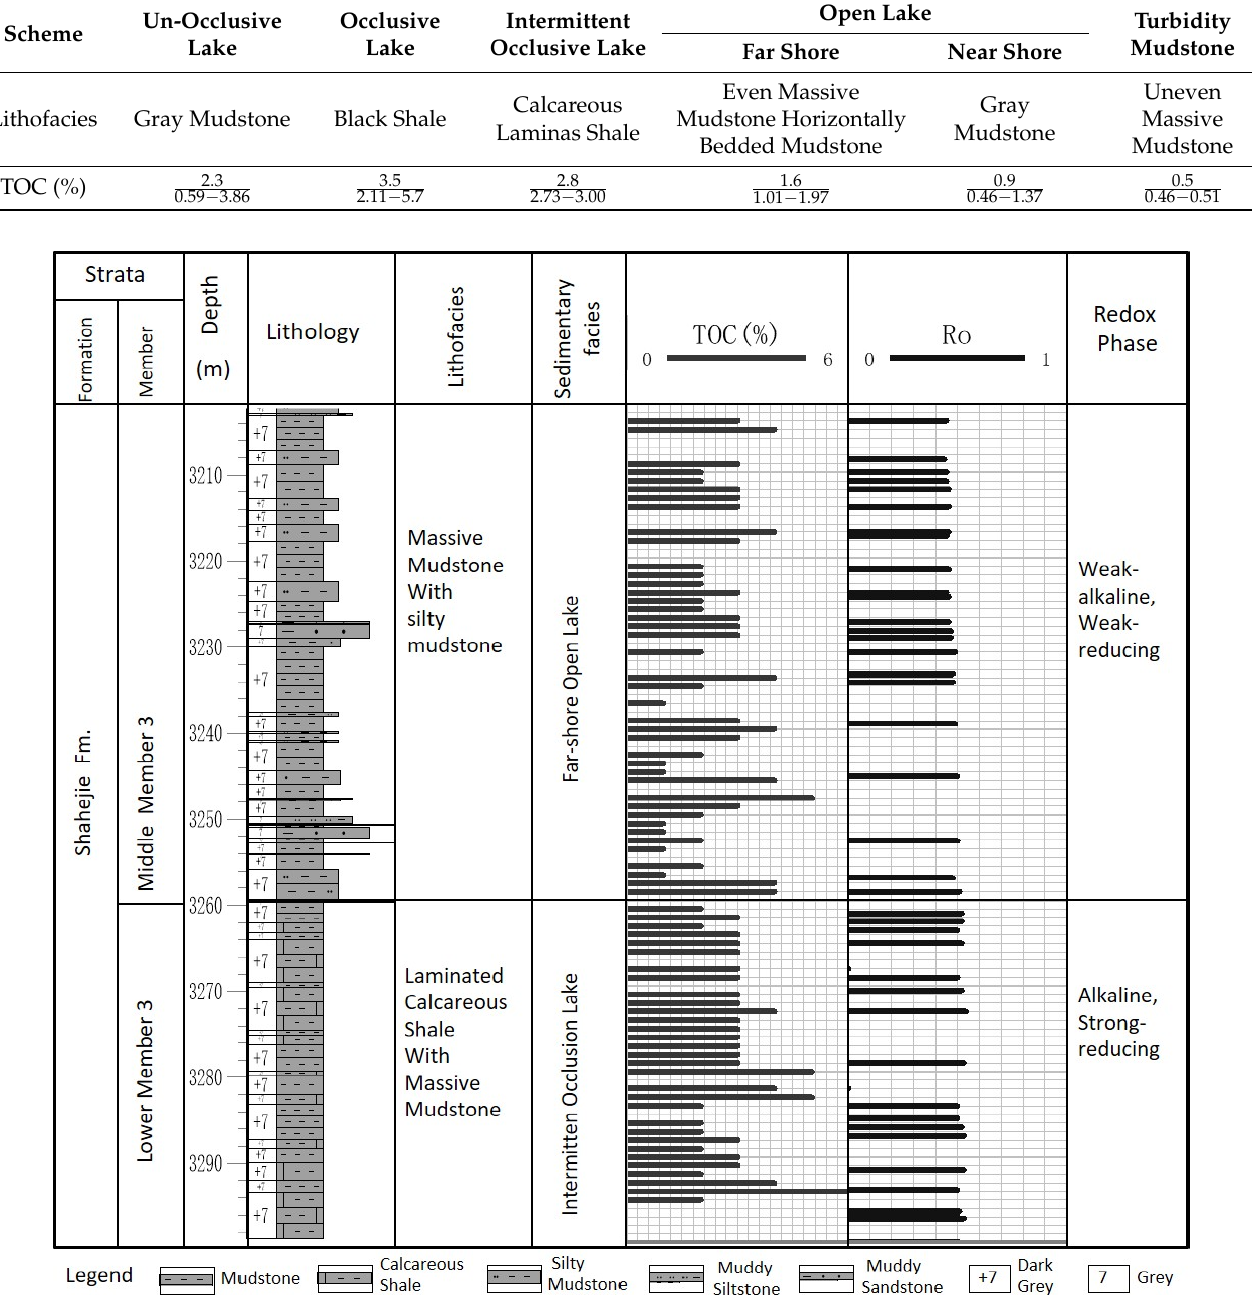
Table 1. TOC contents of lacustrine mudstones in different sedimentary facies (modified after Deng and Qian, 1993 [10]). Scheme